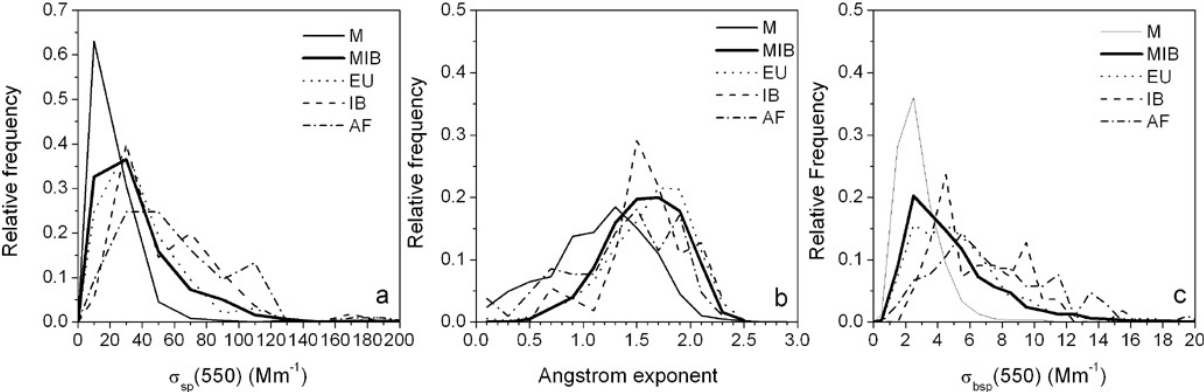
Fig. 8. Relative frequency distributions of (a) σ sp (550) (bin size=20Mm − 1 ) , (b) α (bin size=0.2) and (c) σ sp (550) (bin size=1Mm − 1 ) for each trajectory